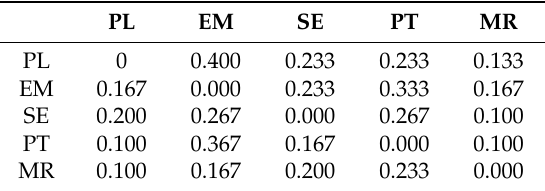
Table 4. Normalized direct-relation matrix X.